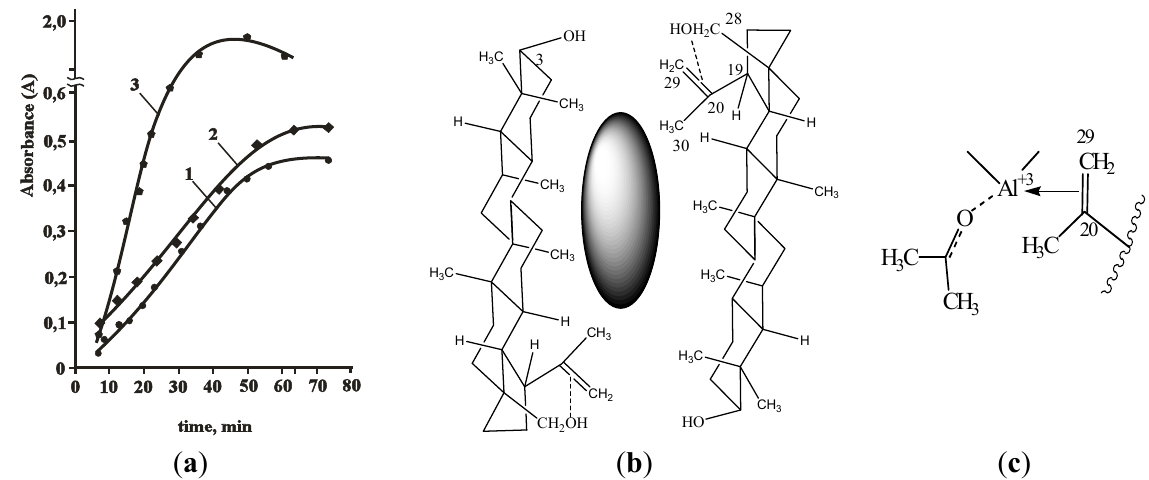
( a ) The changes of absorbance ( A ) at 210 nm of 1% betulin in acetone solution containing H (curve 1), mixture of H dimer as “host” to form inclusion complexes; ( с ) π -complex of Al 3+ with isopropenyl